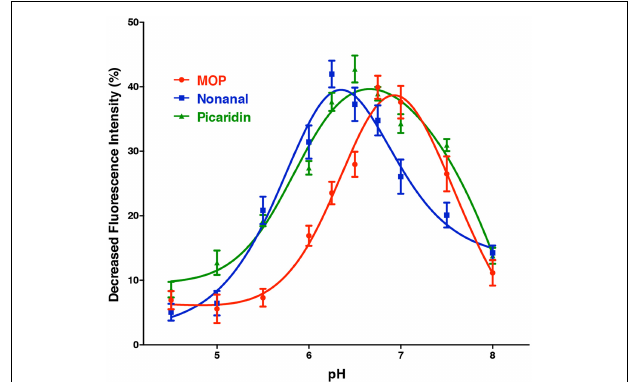
FIGURE 2 | Titration of NPN displacement by high affinity odorants. (A) Binding of picaridin, nonanal and MOP to CquiOBP1. (B) Titration of NPN fluorescence in the presence of CquiOBP2 by 3,5-dimethylphenol, skatole, and PMD. (C) Binding of MOP, nonanal, and picaridin to CquiOBP5.